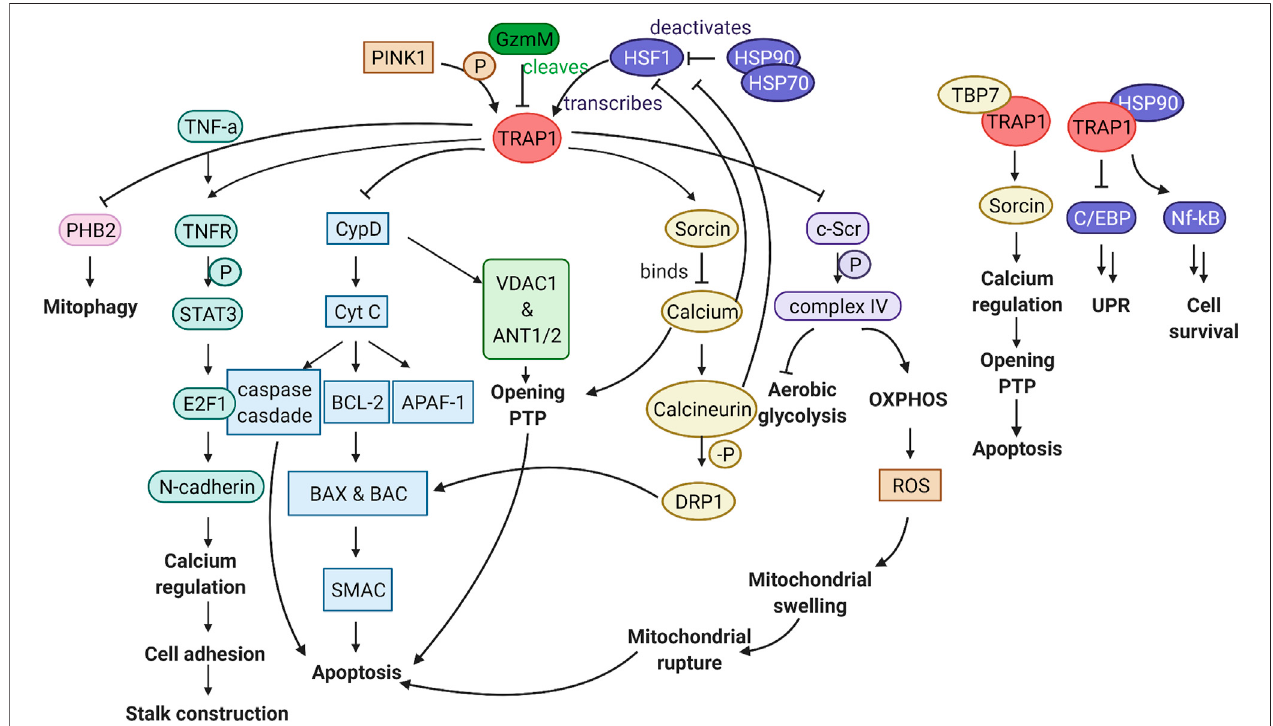
FIGURE 4 | Graphical abstract of the TRAP1 pathway. TRAP1 is transcribed by HSF1, which is deactivated by the HSP90 complex. PINK1 phosphorylation can activate TRAP1, whereas GzmM can cleave TRAP1, thereby hindering TRAP1 activity. Downstream of TRAP1, multiple pathways can in fl uence mitochondrial function and cellular viability. FLTR:TRAP1 interactor PHB2 is inhibited, reducing mitophagy. Stalk construction can be mediated through TNFR1, via STAT3 phosphorylation, activation of transcription factor E2F1, which transcribes N-cadherin responsible for calcium regulation and cell adhesion. Through inhibition of CypD, TRAP1 can prevent mitochondrial pore opening and release of Cyt c to the cytosol, which is critical in the prevention of apoptosis. TRAP1 can in fl uence calcium regulation through Sorcin, which is essential to keep the mitochondrial pores close. By inhibiting c-Scr, TRAP1 acts as a metabolic switch, which results in less ROS production. In associationwithTBP7ontheER,TRAP1canin fl uencecalciumregulationbetweenthemitochondriaandER.TogetherwithHSP90,TRAP1isinvolvedininhibitionofthe unfolded protein response and promoting cell survival. Figure made with BioRender.